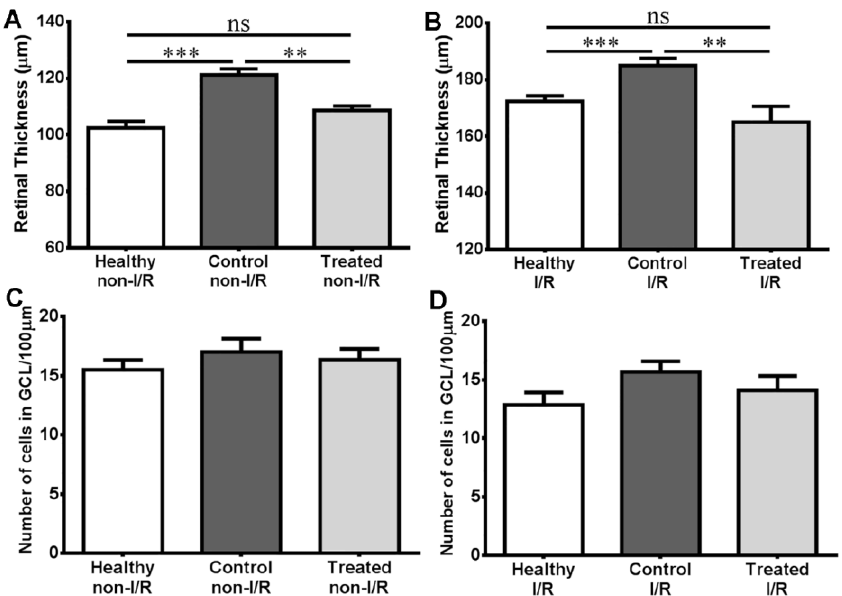
Figure 4. Histology results. ( A ) Retinal thickness of non-ischemic-reperfused eyes of the different groups; ( B ) Retinal thickness of ischemic-reperfused eyes of the different groups; ( C ) Number of cells in ganglion cell layer per unit distance (100 μm) in non-ischemic-reperfused eyes of the different groups; ( D ) Average number of cells in ganglion cell layer per unit distance (100 μm) in ischemic-reperfused eyes of the different groups. Values are mean ± SEM; ns = no significant difference; ** p < 0.01; *** p < 0.001. In panels C and D, no significant differences are seen.